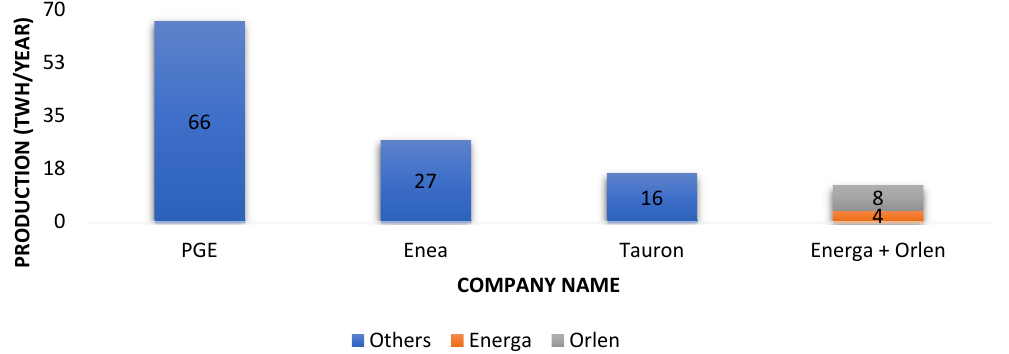
Figure 6. Electricity market after Energa acquisition by Orlen–production [TWh/Year]. Source: author’s study based on: https://wysokienapiecie.pl/24792-orlen-chce-przejac-energe/ (access date: